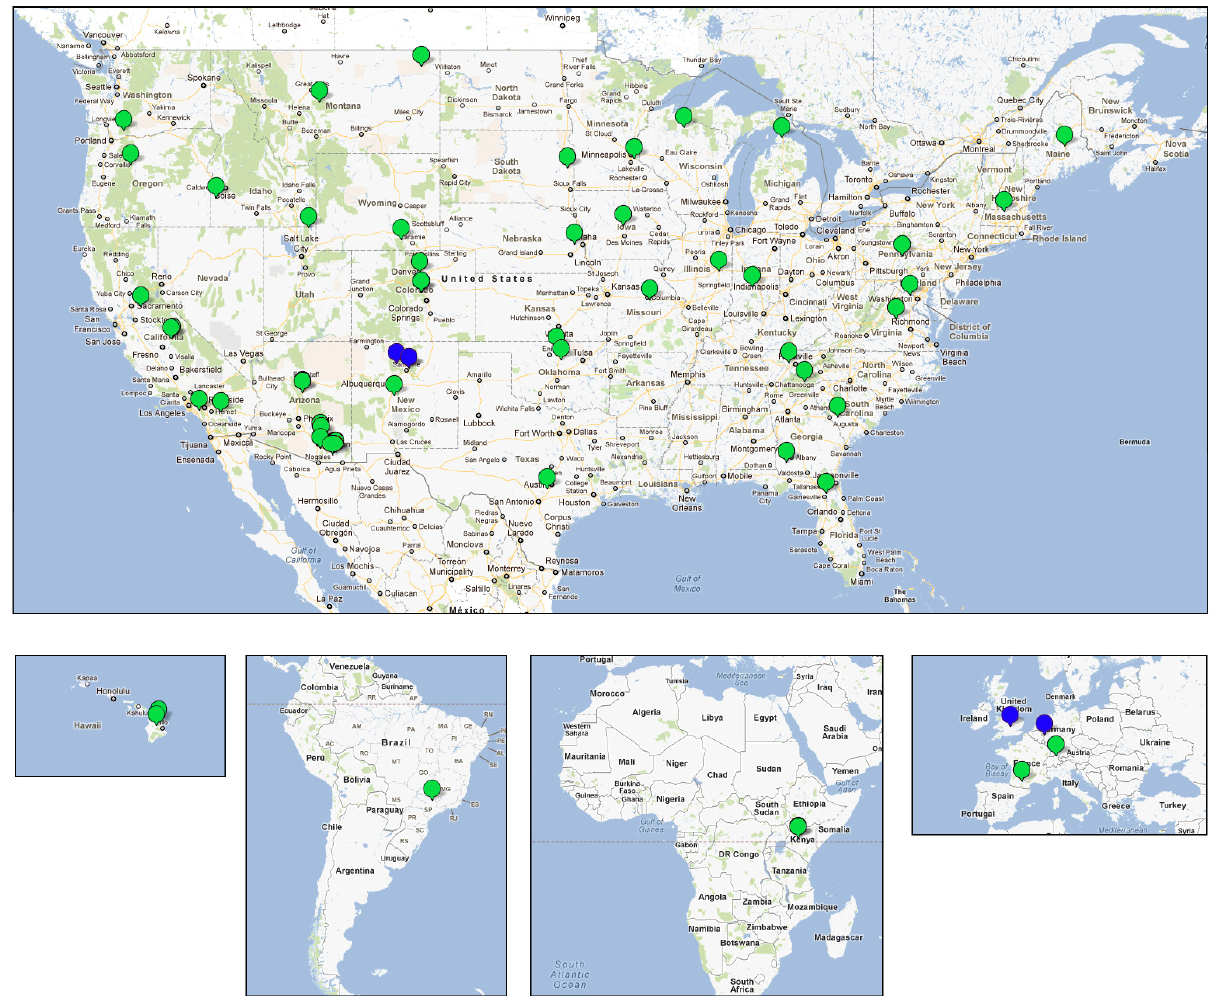
Fig. 8. Fifty-three COSMOS probes (green) and five COSMOS-affiliated probes (blue) installed before March 2012; ten additional probes are planned for deployment in 2012. Up-to-date information on the sites is available at